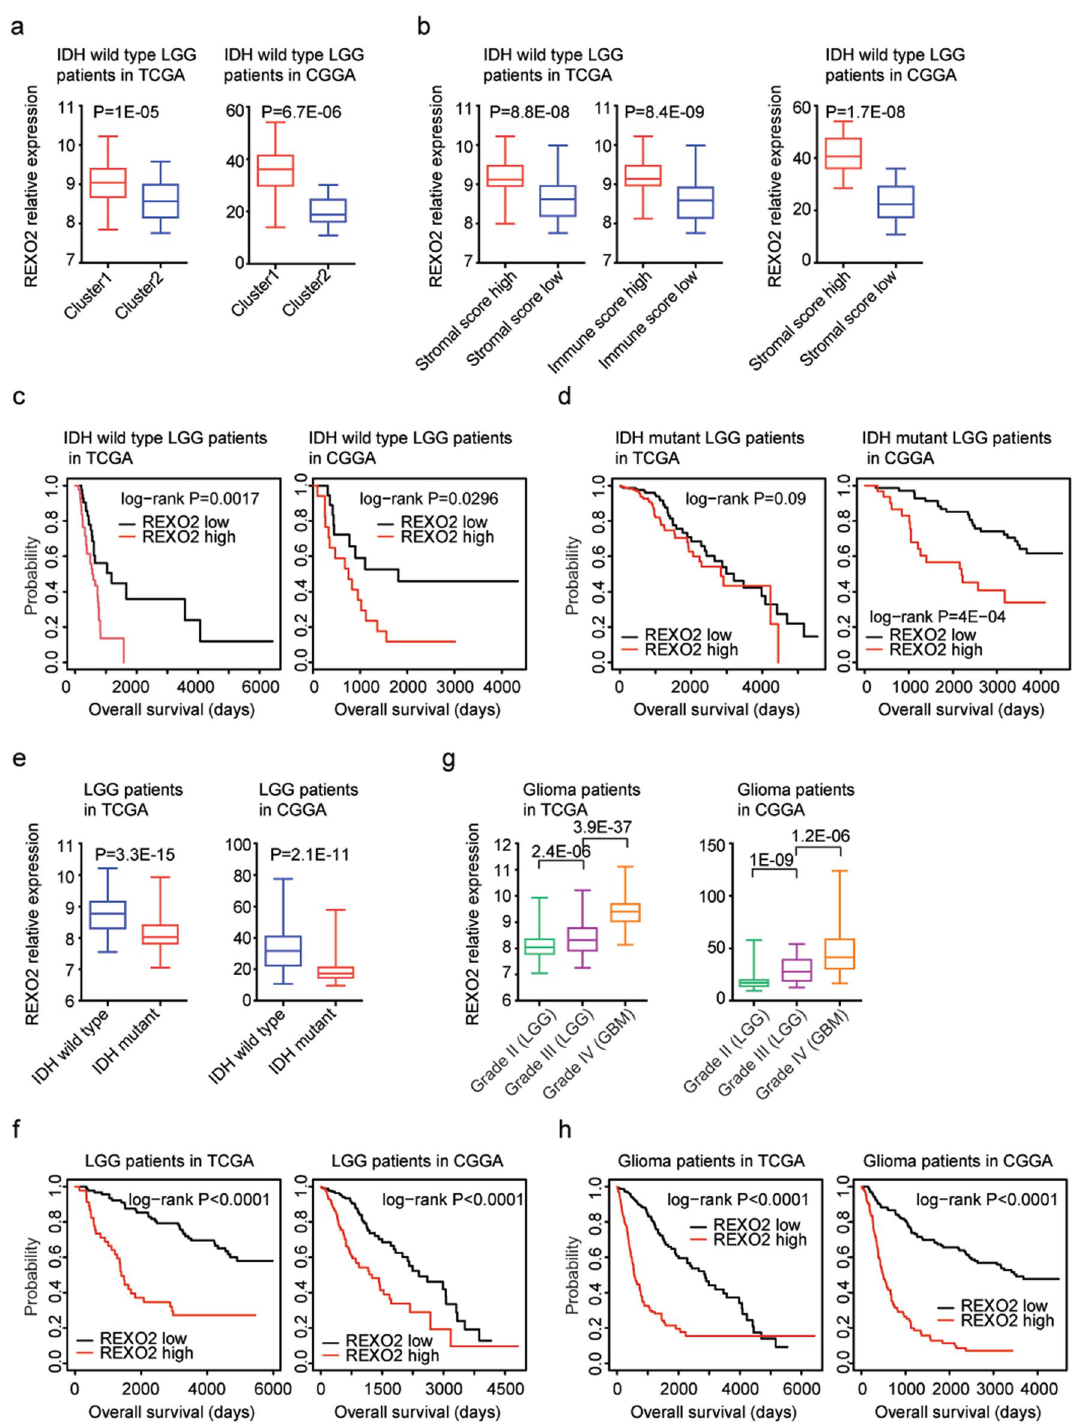
Figure 6. REXO2 is up-regulated in sub-cluster1 and associated with the worse clinical outcomes of IDH wild type or IDH mutant LGG or glioma patients. ( a ) Box plots showed the expression levels of REXO2 in sub-cluster1 and sub-cluster2 IDH wild type LGG patients in TCGA and CGGA datasets. ( b ) Box plots showed the REXO2 expression levels in TCGA and CGGA IDH wild type LGG patients with higher stromal or immune score (red) or with lower stromal or immune score (blue). ( c ) The Kaplan–Meier Plotters showed the overall survival of REXO2 highly expressed IDH wild type LGG patients (red) and REXO2 lowly expressed IDH wild type LGG patients (black) in TCGA and CGGA datasets. ( d ) The Kaplan–Meier Plotters showed the associations between REXO2 expression and overall survival in IDH mutant LGG patients in TCGA and CGGA datasets. ( e ) The expression levels of REXO2 in LGG patients with (red) or without (blue) IDH mutations in TCGA and CGGA datasets. ( f ) The Kaplan–Meier Plotters showed the correlations of REXO2 expression levels and LGG overall survival in TCGA and CGGA datasets. ( g ) Box plots demonstrated the expression levels of REXO2 in grade II (LGG), grade III (LGG) or grade IV (GBM) glioma patients in TCGA and CGGA datasets. ( h ) The Kaplan–Meier Plotters showed the correlations of REXO2 expression levels and glioma overall survival in TCGA and CGGA